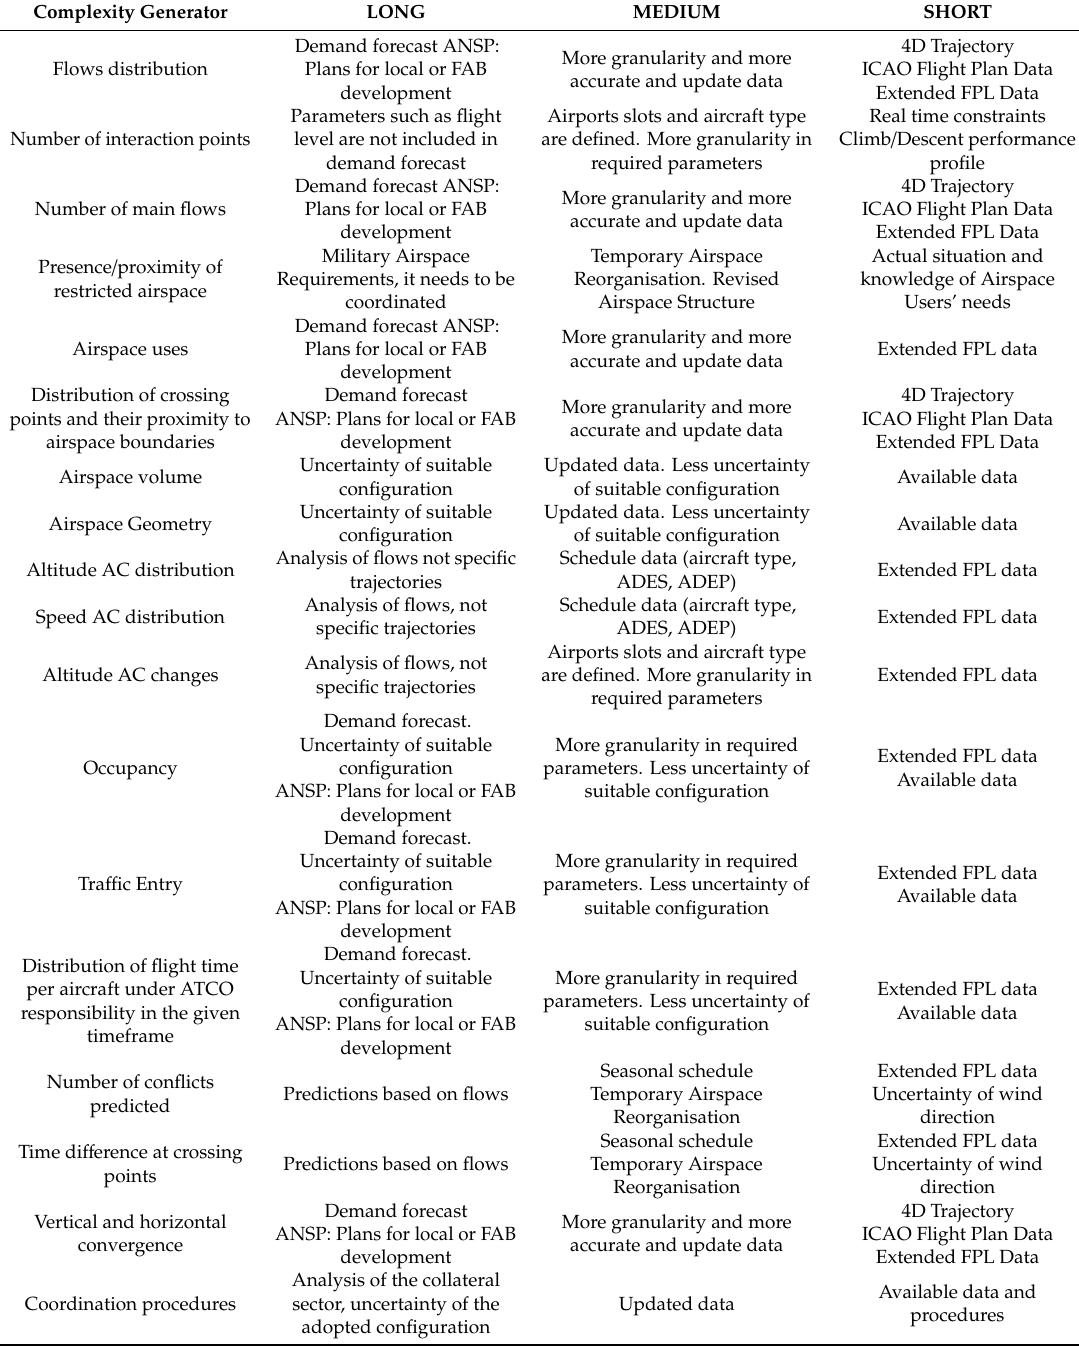
Table 5. Uncertainty of CGs at each Time Horizon in